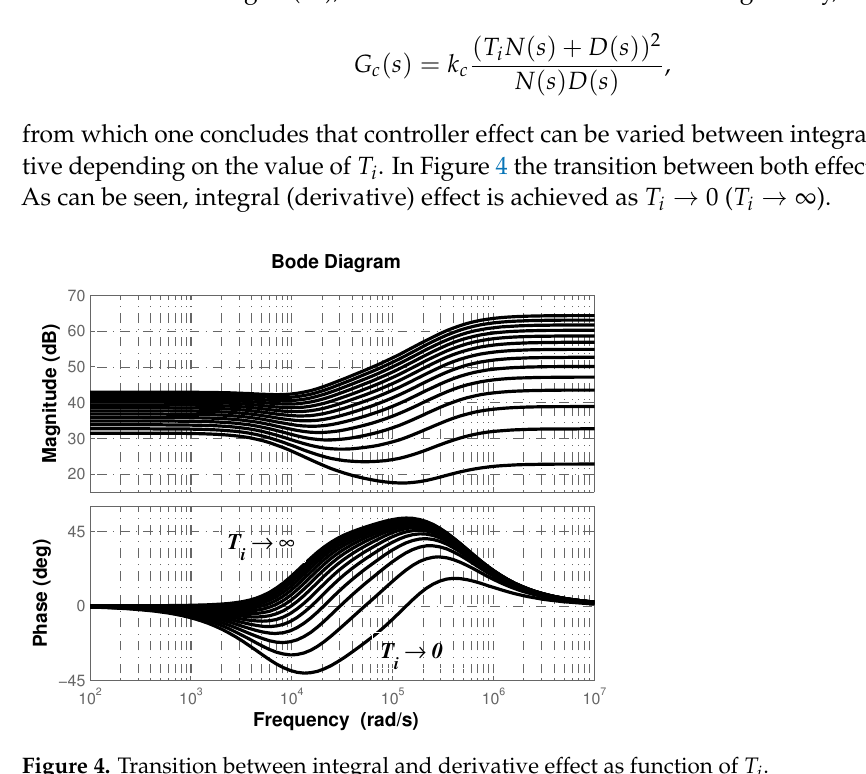
Figure 3. Frequency response of fractional-order approximation for buck/boost conversion modes. The controller G c ( s ) can be obtained by manipulating (9) as s α ≈ T ( s ) ≡ N ( s ) / D ( s ) and then substituting in (14), thus the controller structure will be given by,